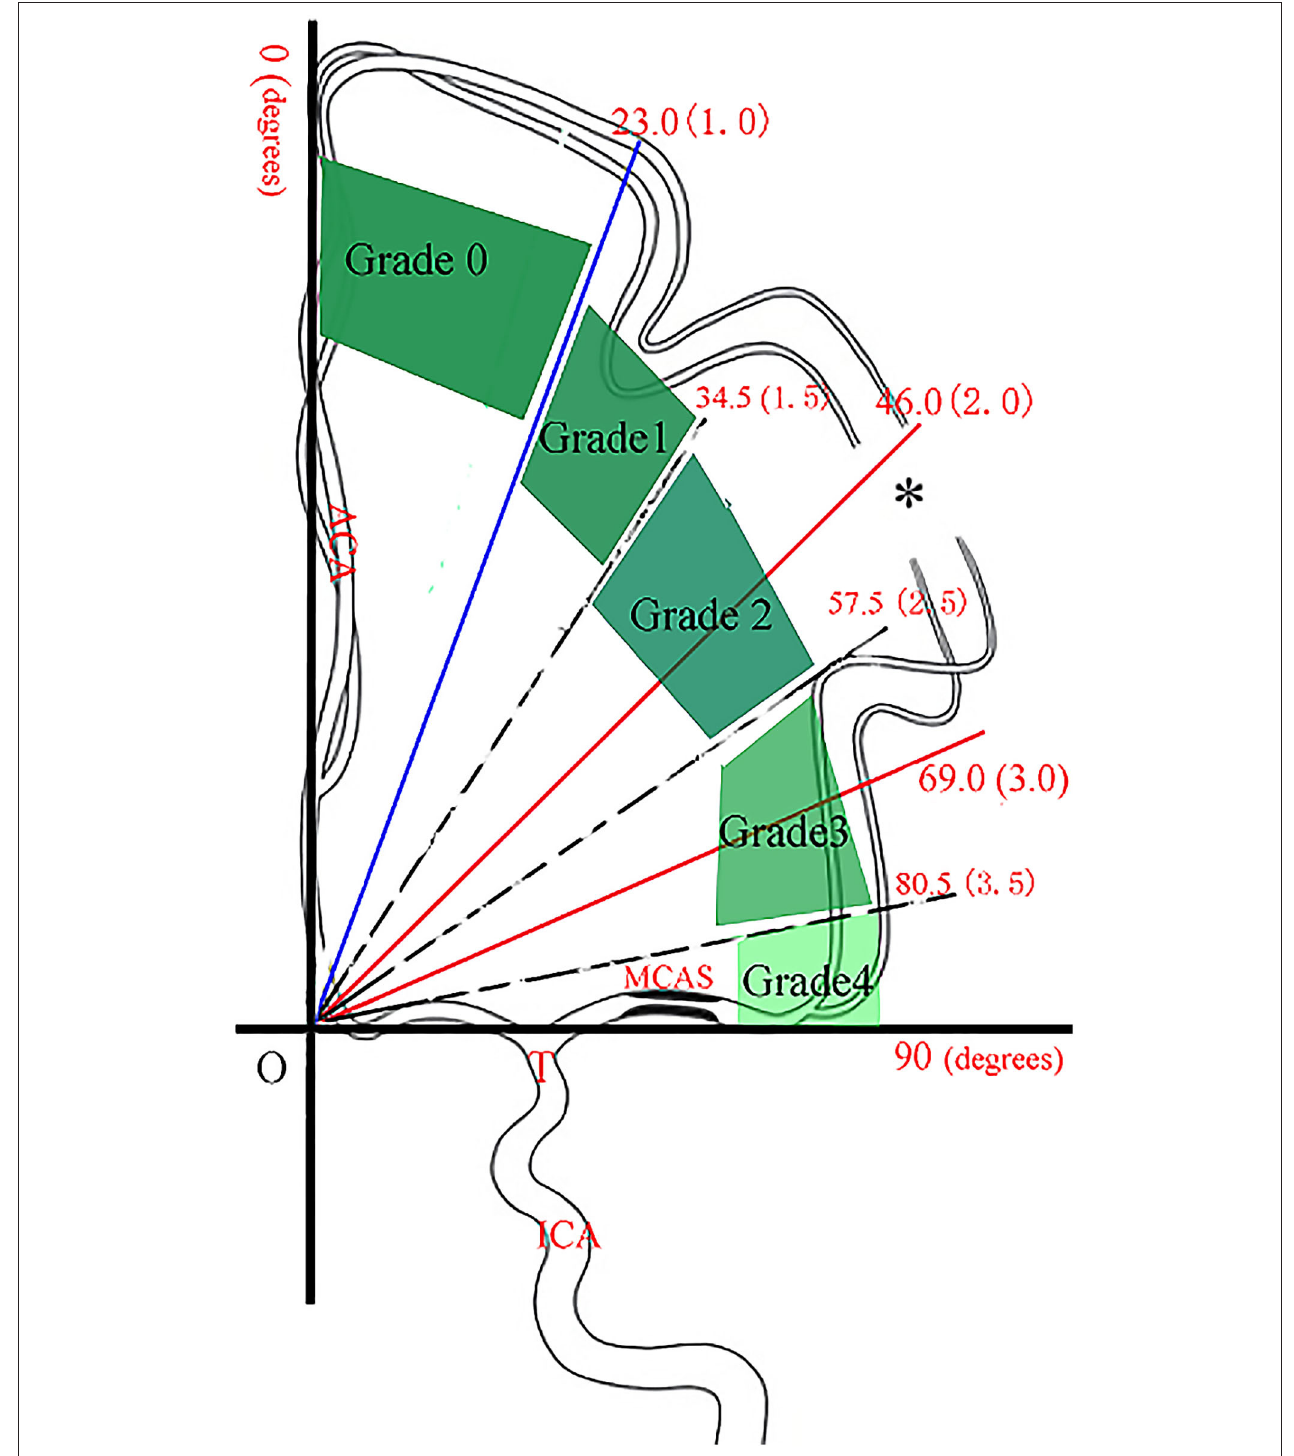
FIGURE 3 | The classification method of ABZA-grading (with permission) (6). On the coordinate graph, point T is the end bifurcation point of internal carotid artery, the vertical line is the middle line of the sagittal sinus, and OT is the vertical line of the middle line. * indicates the central point at which the pia mater arterioles of ACA and MCA first met. The vertical area is divided into four parts from three solid lines, corresponding to ABZA: 23.0 ◦ , 46.0 ◦ , and 69.0 ◦ . In addition, the three dashes correspond to ABZA: 34.5 ◦ , 57.5 ◦ , and 80.5 ◦ . The red number in each bracket indicates the corresponding ABZA-trans (ABZA/23.0 ◦ ), and when rounded it up, the integer number is the corresponding collateral score